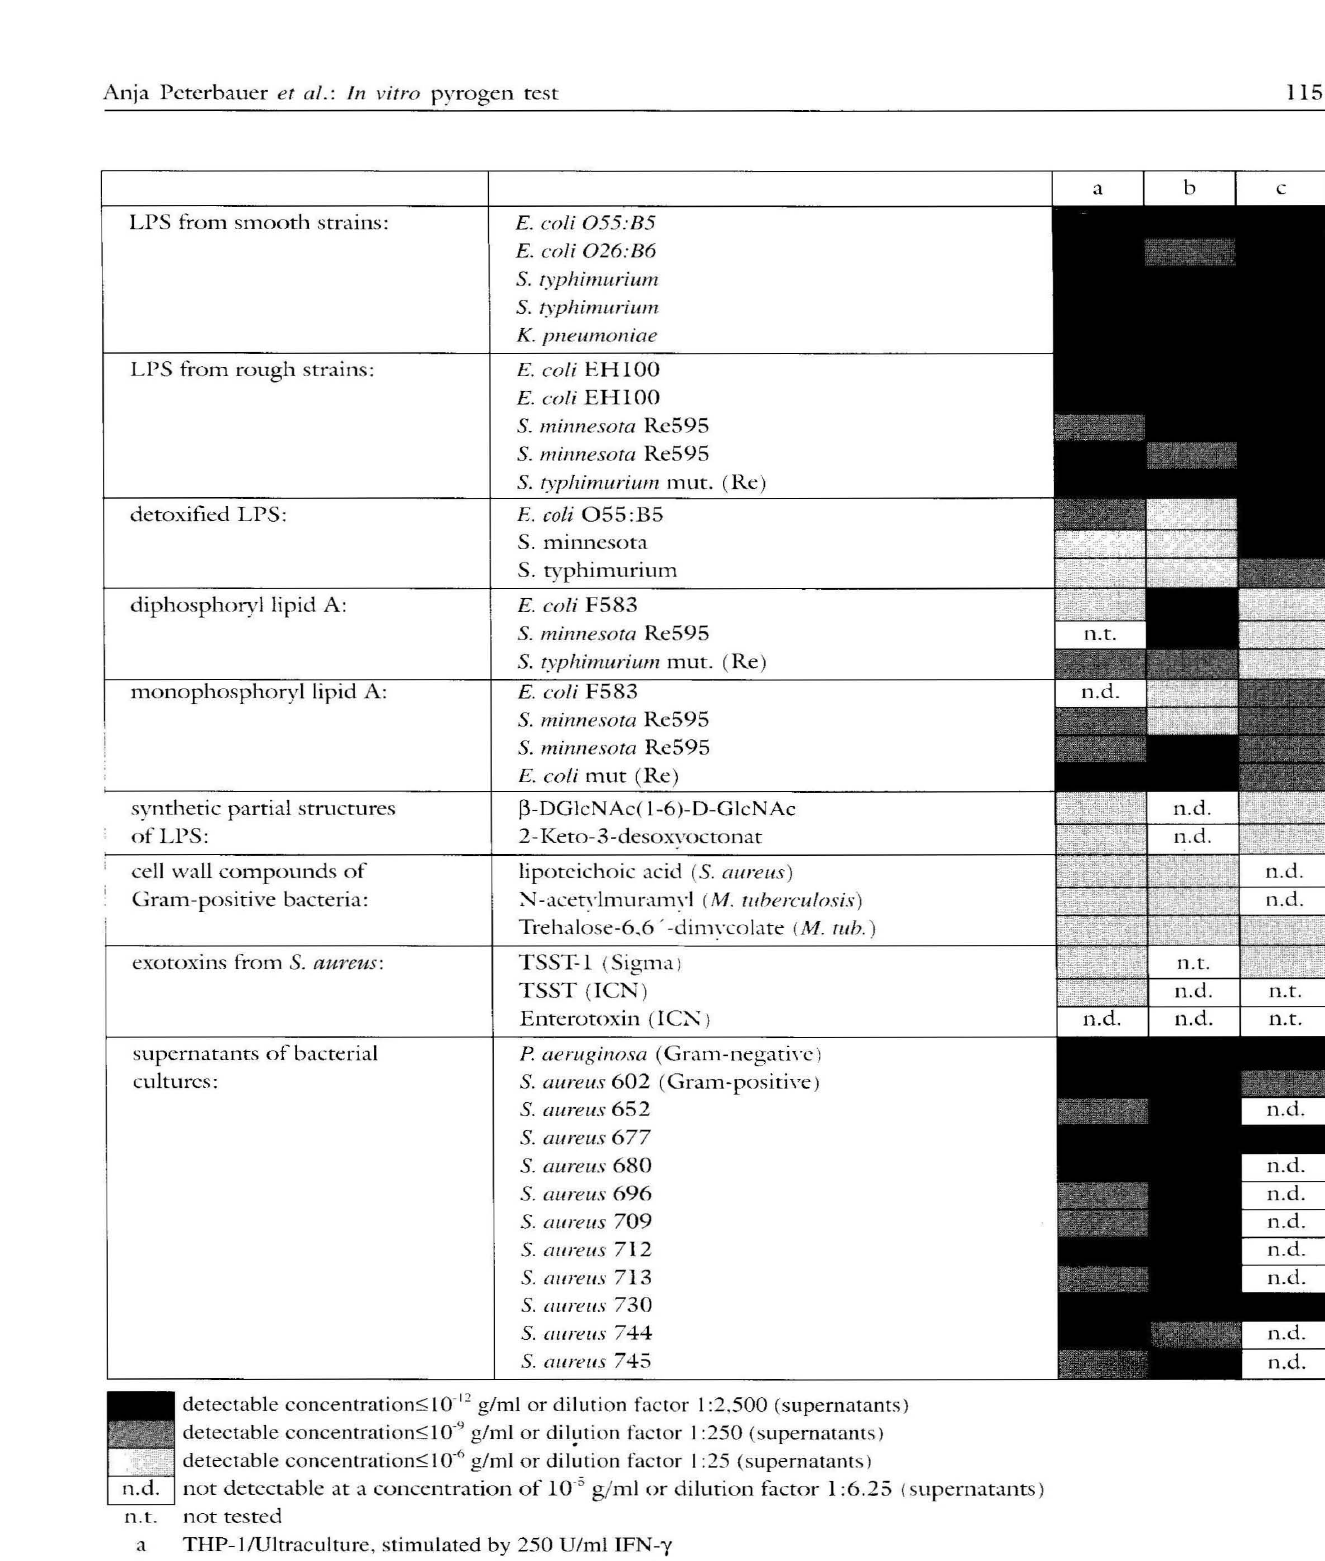
Pteridines / Vol. 10 /